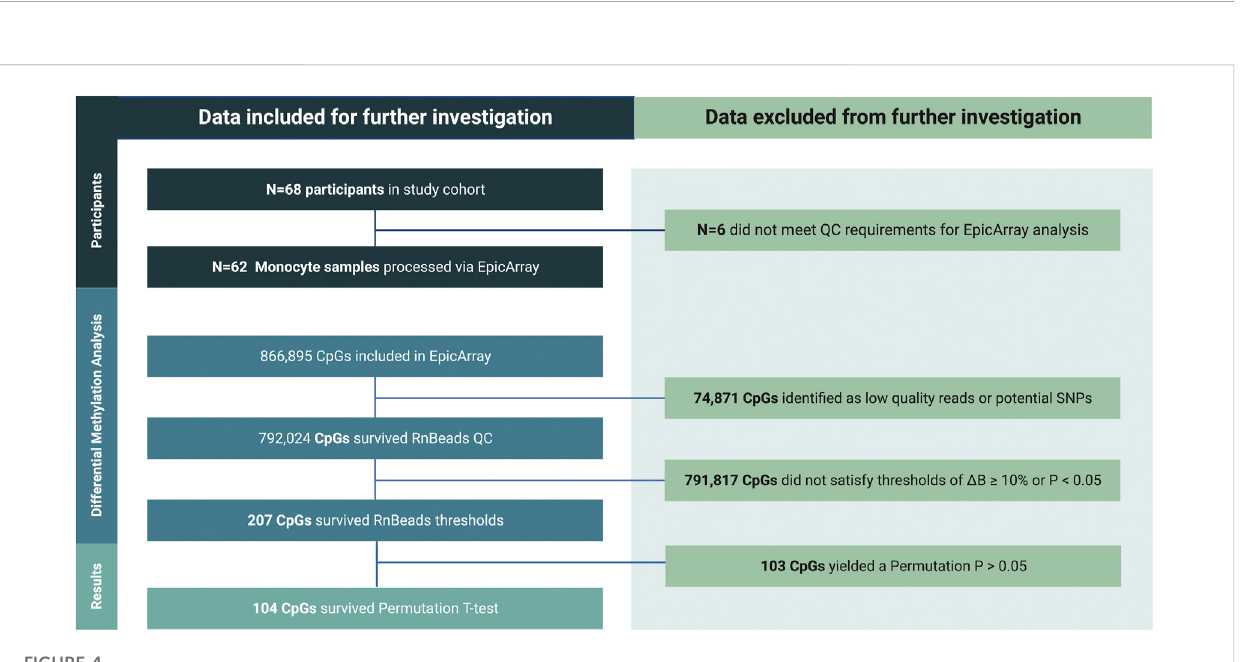
51; 49%) were located in intergenic regions, most ( N = 34; 67%) of which were hypermethylated with respect to LSE. Signi fi cant differences between the number of DML hypo- and hyper- methylated were found predominantly at 5 ′ UTR and intergenic regions (Supplementary Figure S1C), potentially indicating functional differences in transcription of associated genes.